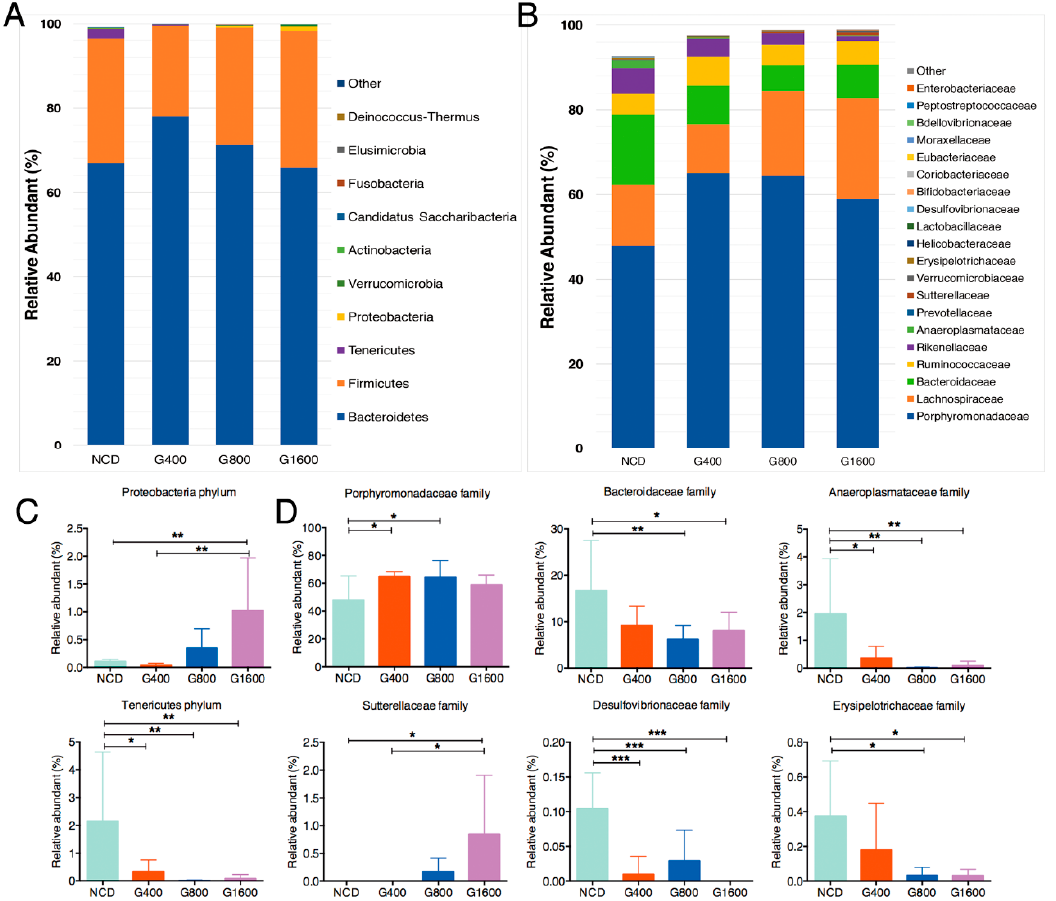
Figure 4. GML altered the fecal microbiota composition in mice. Microbial taxonomic profiling in the ( A ) phylum level and ( B ) family level among different groups, and different colors represent different taxa. Relative abundance of the bacterial ( C ) phylum and ( D ) families that differentially detected in fecal samples. Results were expressed as mean ± SD ( n = 8–10), * p < 0.05; ** p < 0.01; *** p < 0.001.